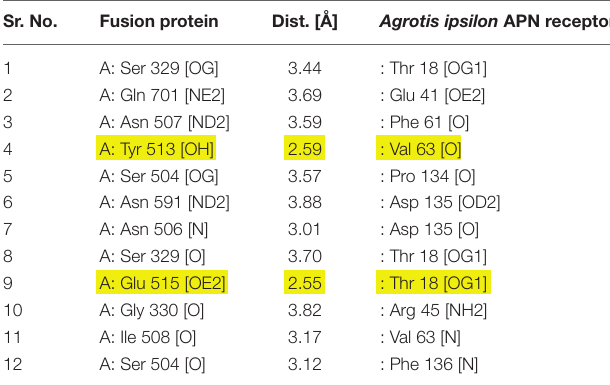
TABLE 1 | Interaction of fusion protein with Agrotis ipsilon APN receptor. Sr. No.